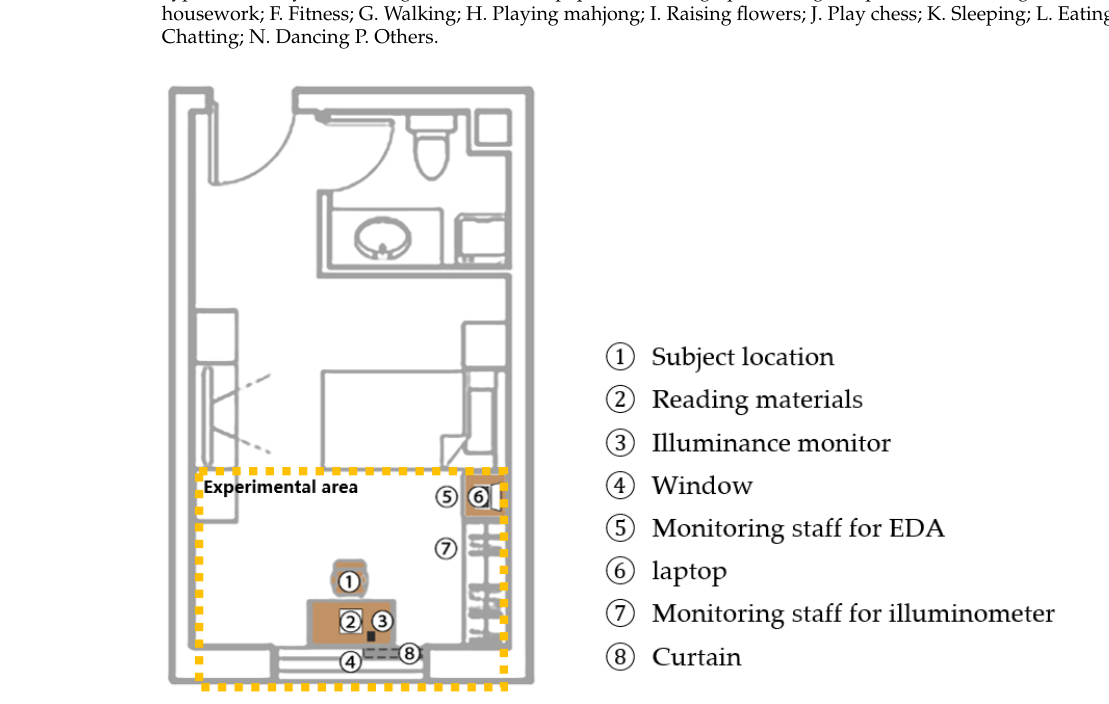
Table 1. The general situation of nursing homes.